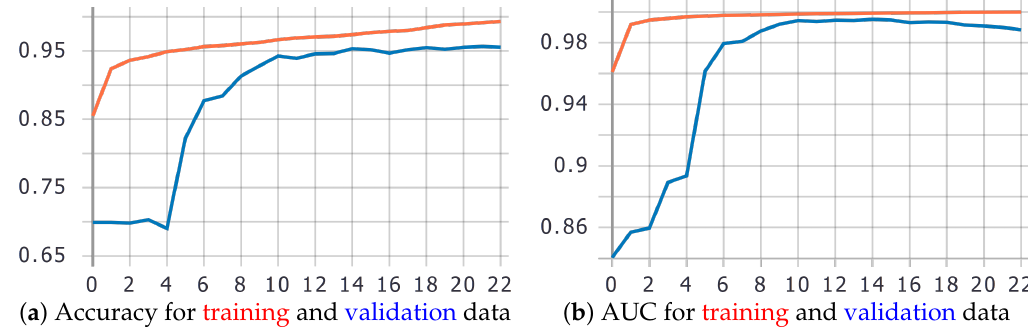
Figure 4. Learning curves—accuracy and AUC among the epochs.